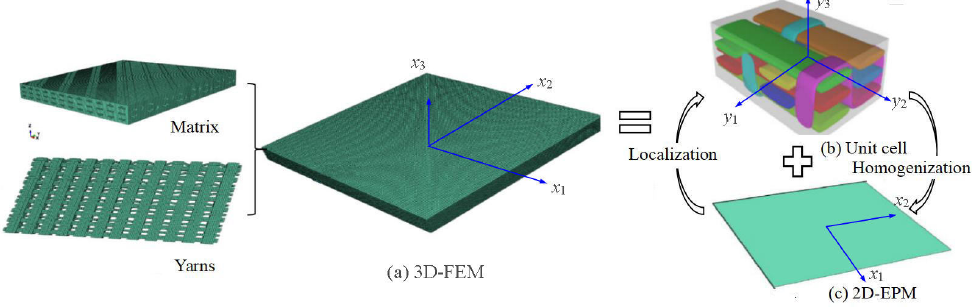
Figure 1. Decomposition diagram of 3D textile composite plate: ( a ) 3D-FEM; ( b ) Unit cell; ( c )